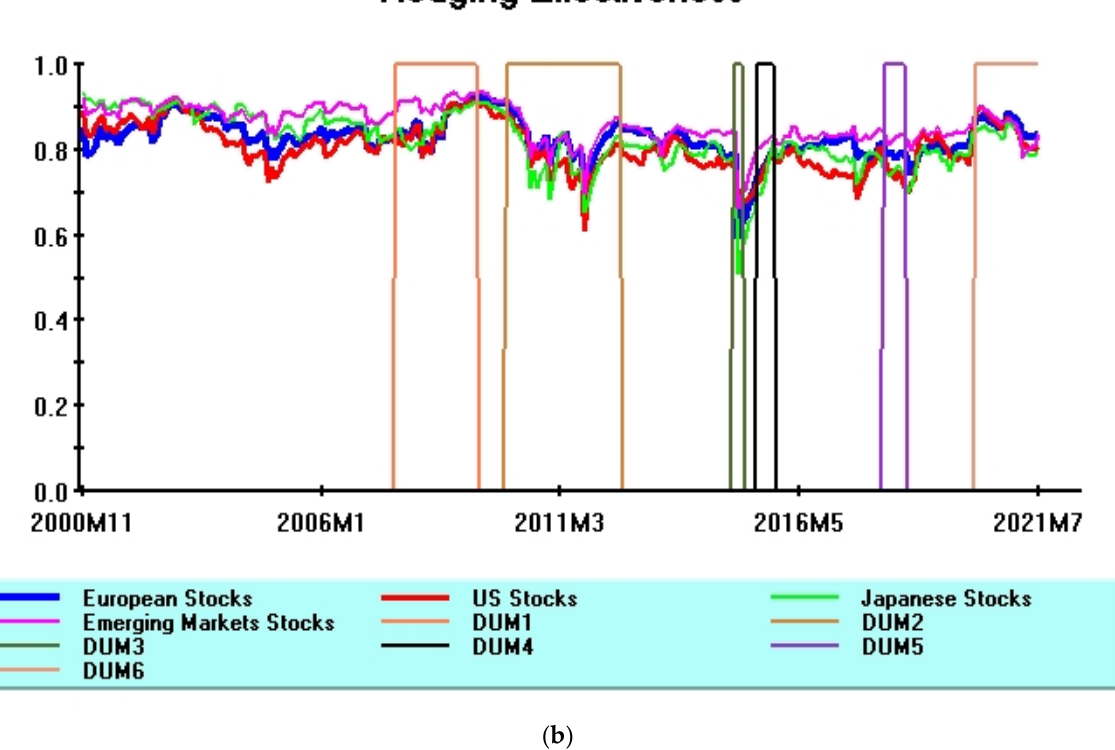
Figure 3. ( a ) Gold as a safe haven asset; ( b ) Swiss Franc as safe haven asset.